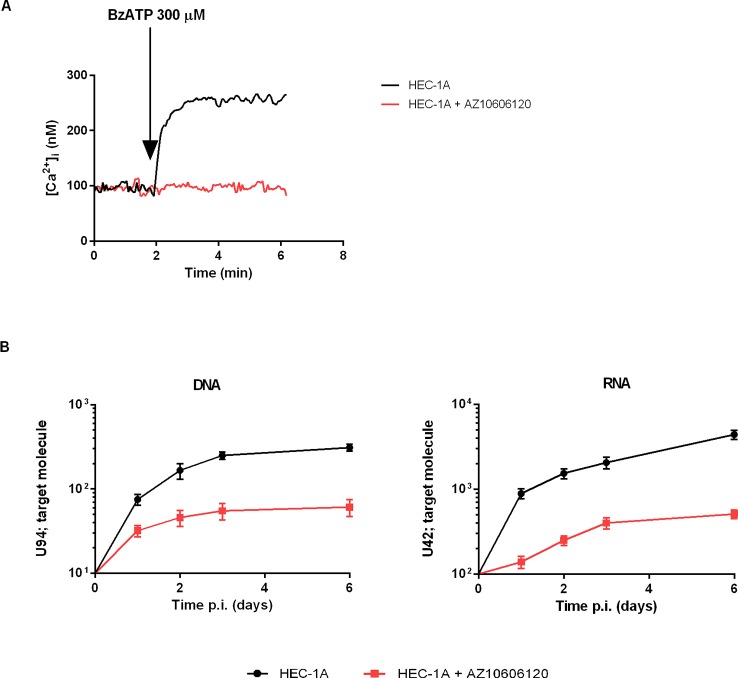
Demonstration of functional P2X7R in the endometrial cancer cell line HEC-1A and infection with HHV-6A virus. HEC-1A carries the P2X7R 489TT genotype. (A) Representative trace showing P2X7R-dependent intracellular calcium increase following cells stimulation with BzATP (300 µM) alone (black) or in the presence of P2X7R antagonist AZ10606120 (2 μM, red). (B) HHV-6A infection in HEC-1A cells. Cells were infected with 100 genome equivalents per 1 cell of HHV-6A for 2 h at 37°C. U94 DNA and U42 RNA were quantified by real-time PCR and RT-PCR as reported in Materials and Methods. Black control cells, red cells pretreated with 2 μM AZ10606120.